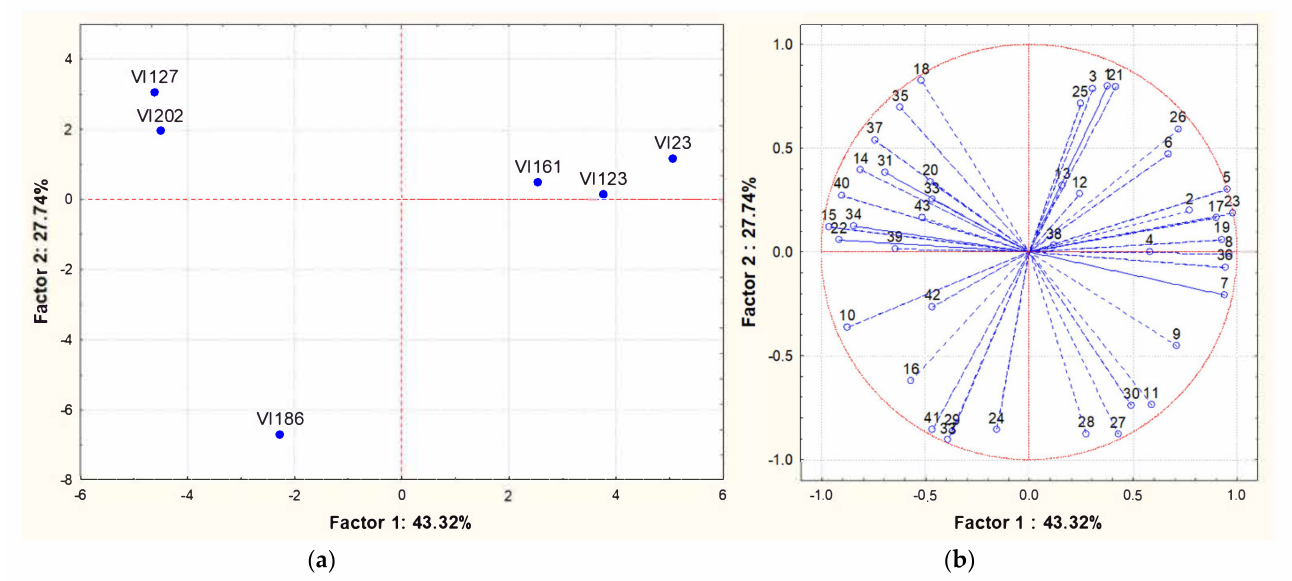
Figure 3. Principal Component Analysis carried out on volatile compounds content in wines obtained by different S. cerevisiae indigenous strains (VI 23 -VI 123 - VI 127 -VI 161 - VI 186 and VI 202). ( a ): similarity map determined by Principal Component (Factor) 1 and 2; ( b ): projection of the variables on the factor plane. Variables: (1) Ethyl acetate; (2)